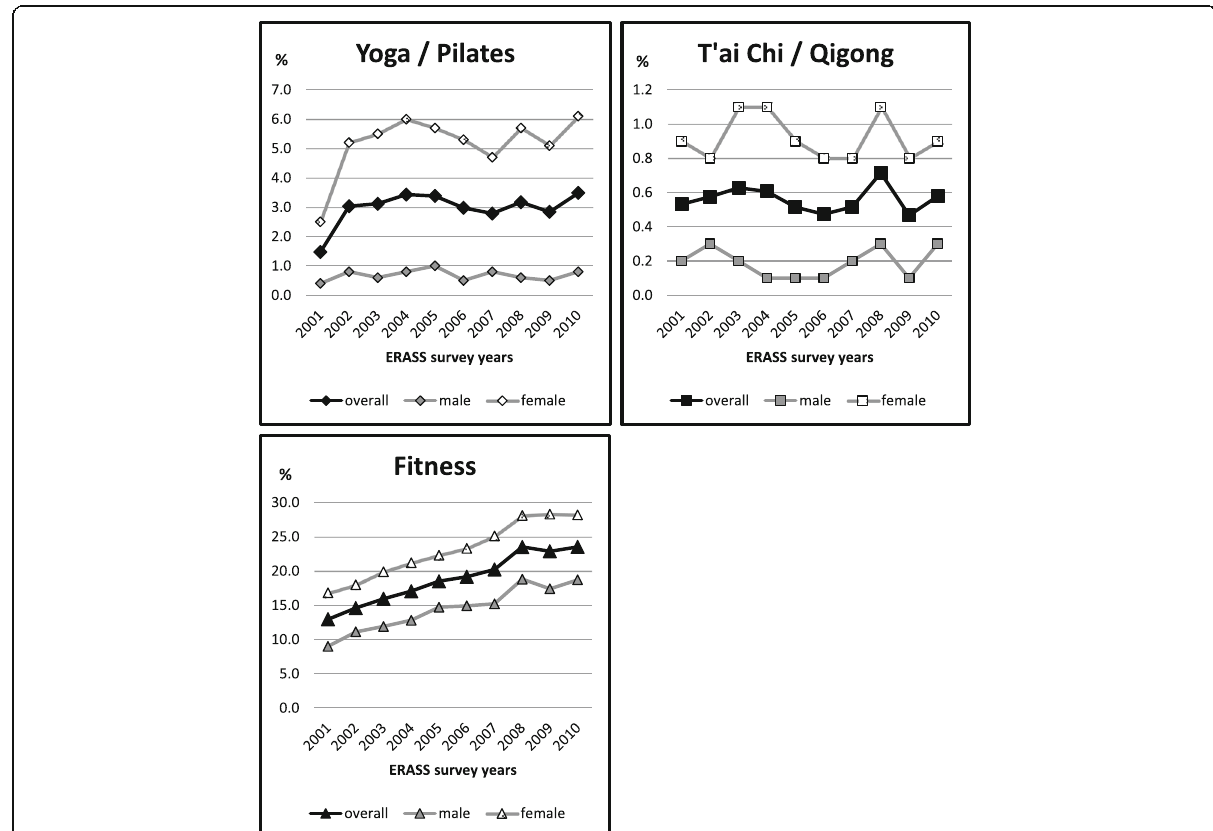
Fig. 1 Ten-year participation trends in yoga/Pilates, t ’ ai chi/qigong and fitness, showing prevalence rates for all participants ( “ overall ” ) and separately for males and females